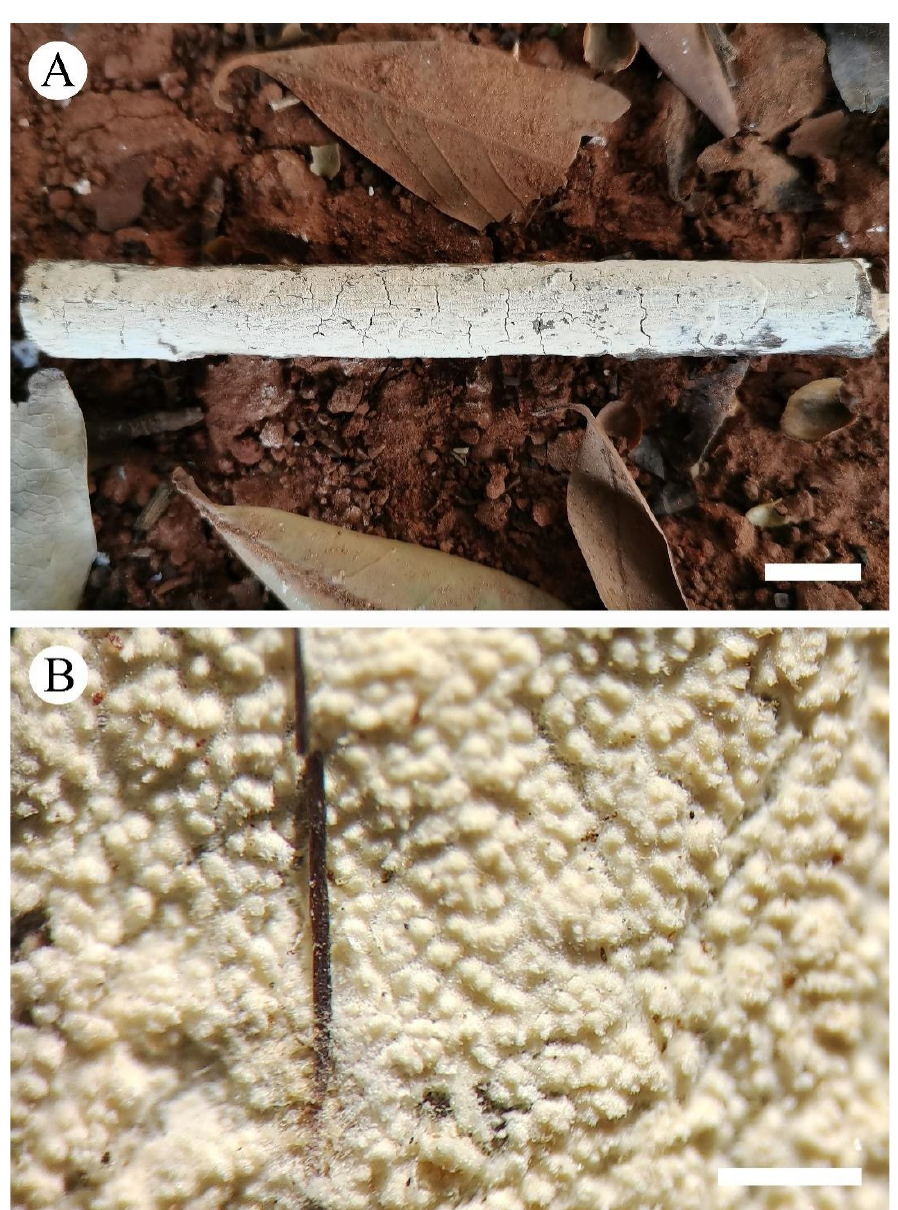
Figure 3. Basidiomata of Xylodon grandineus (holotype): the front of the basidiomata ( A ), characteristic hymenophore ( B ). Bars: ( A ) = 1 cm and ( B ) = 1 mm.